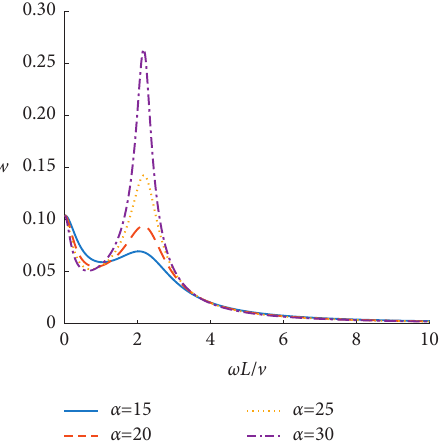
Figure 5: Influence of the parameter α on the deflection amplification factor at the midpoint of the beam.